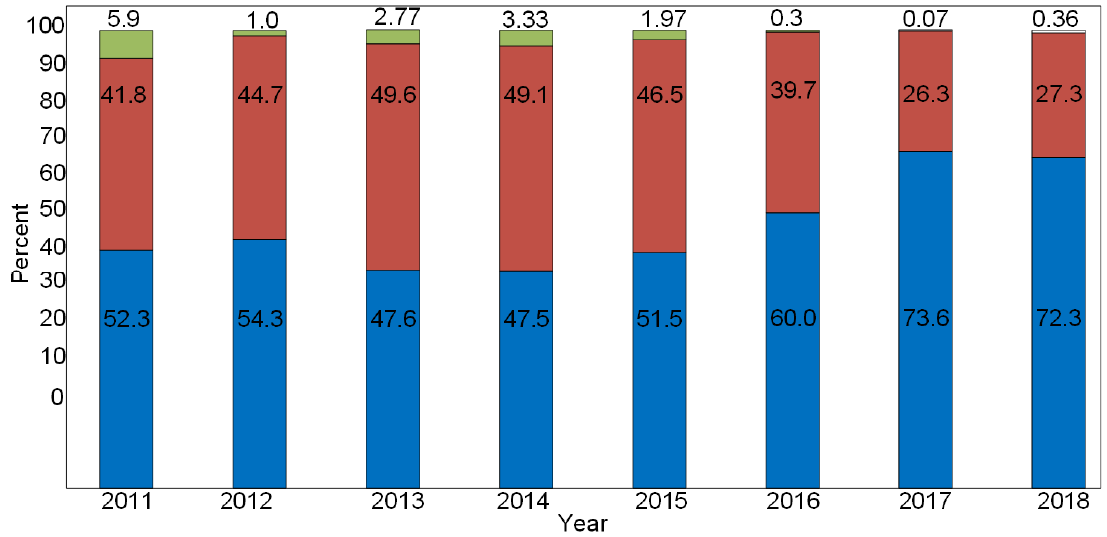
Figure 18. Percentage composition of electricity generation in Ecuador.